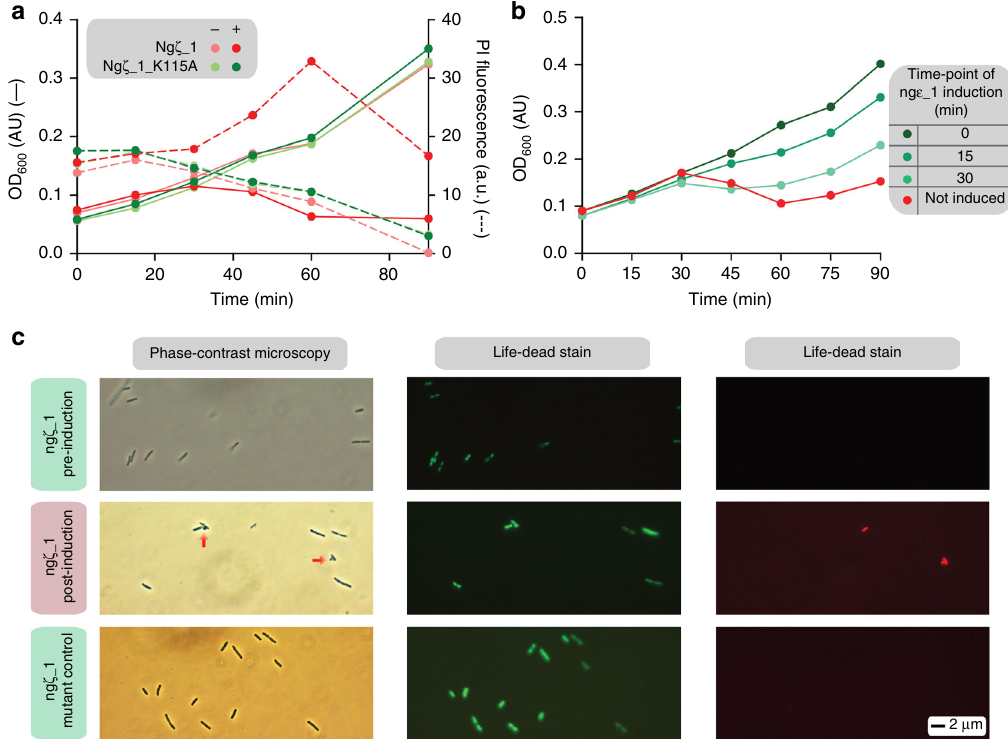
Fig. 1 Ng ζ _1 expression in E. coli cells causes a lytic phenotype compensated by ng ε _1 co-expression. a Growth curves of E. coli C41(DE3) cells expressing ng ζ _1 (red solid line and left Y -axis) or ng ζ _1(K115A) (forest-green solid line and left Y -axis) together with the corresponding propidium iodide in fl ux into the cells (dashed lines similarly colored and right Y -axis). Control experiments in which expression of ng ζ _1 or ng ζ _1(K115A) was not induced are shown in light pink and lime-green. Note that growth curves of the two uninduced cell cultures as well as the PI measurements of the mutated variant (induced and not induced) fully overlay with each other. b Growth curves of E. coli BL21(DE3)-RIL cells co-expressing ng ζ _1 and ng ε _1. Expression of ng ε _1 was induced 0 (forest-green), 15 (lime-green) and 30 min (pale-green) subsequent to ng ζ _1 induction. The control experiment in which expression of ng ε _1 was not induced is shown in red. c Phase contrast and fl uorescence microscopy (live-dead stain) of E. coli C41(DE3) cells before and after ng ζ _1 induction (30 min) and the control experiment using the inactive ng ζ _1(K115A) mutant. Cells with green fl uorescence have intact cell membranes and are alive. Membrane permeable cells have red fl uorescence due to propidium iodide in fl ux. Resolved bulges due to cell wall extrusions in phase-contrast microscopy images are highlighted with red